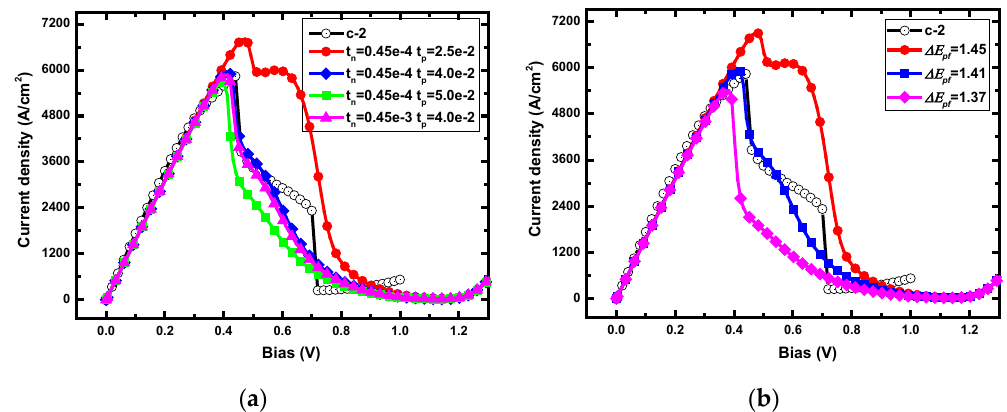
Figure 7. Influence of ( a ) trap carrier lifetime and ( b ) Poole–Frenkel shift on simulated J-V curve. The experimental data are from sample c-2.